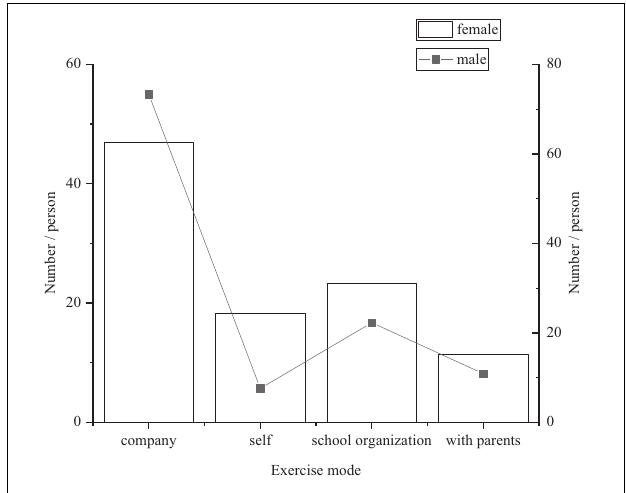
FIGURE 2 | Statistical chart of physical exercise percentage for boys and girls.